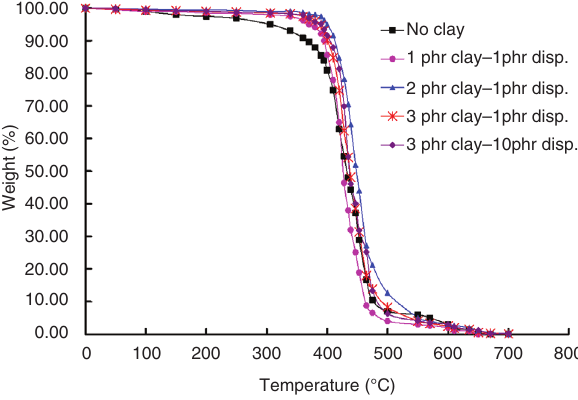
Figure 4 Differential thermal analysis plots for different clay